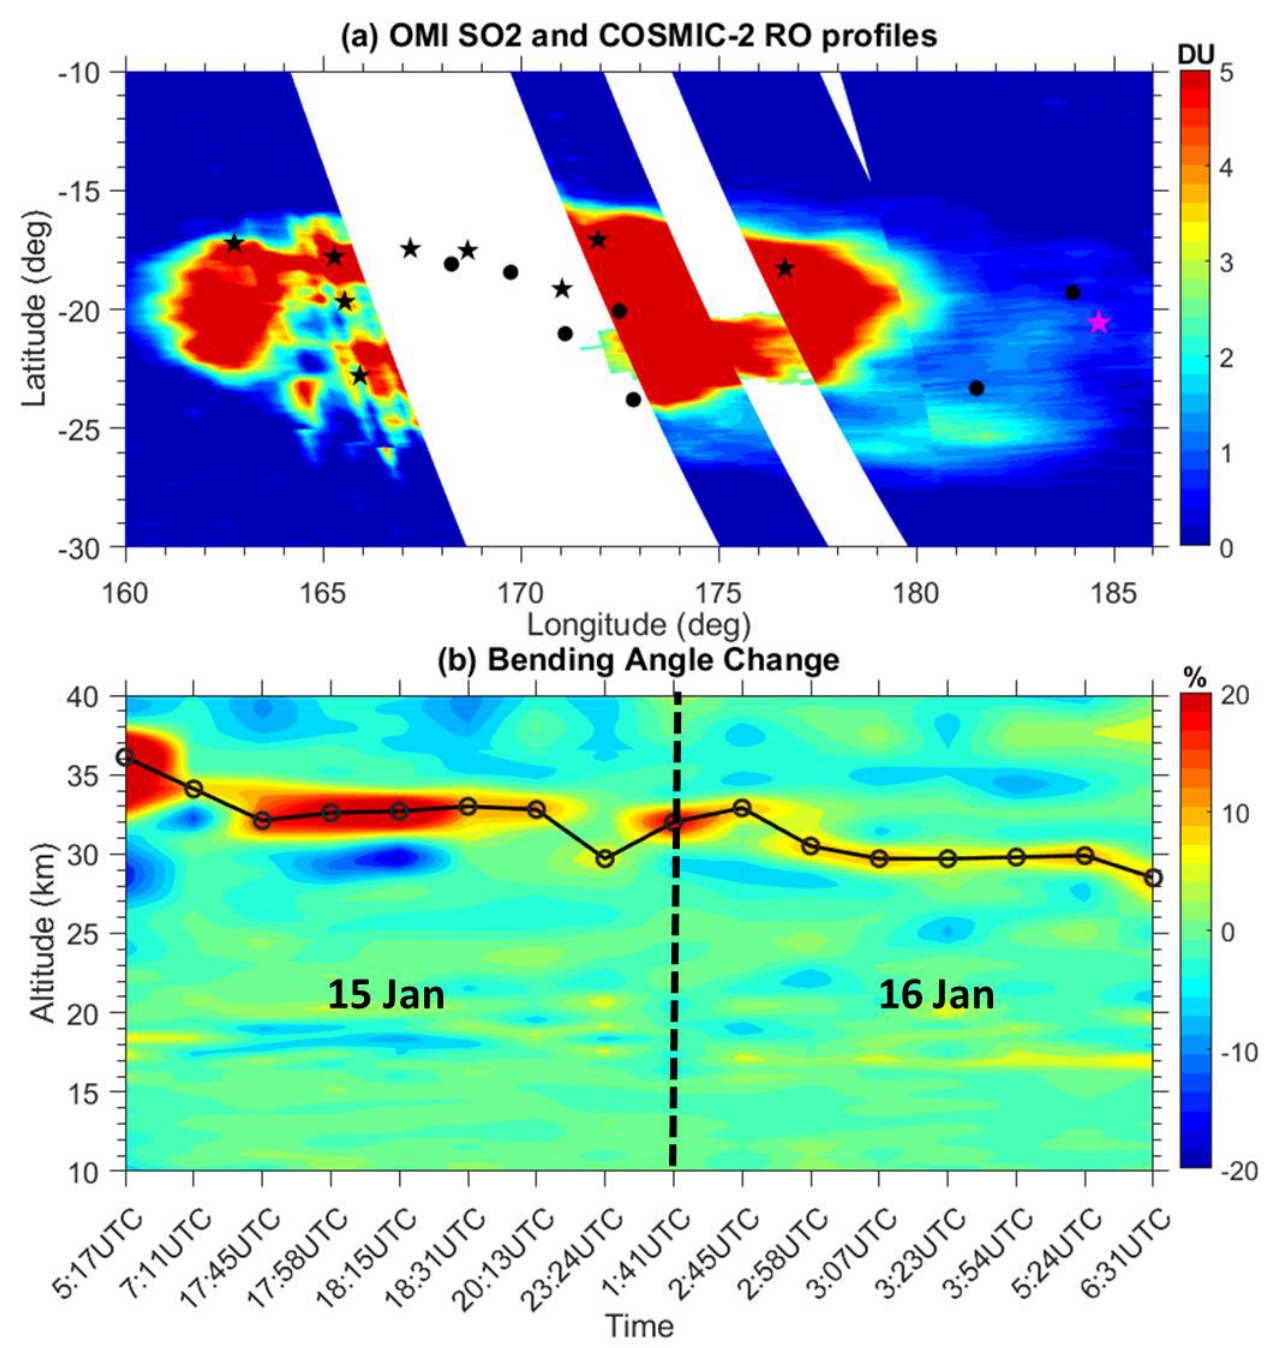
Figure 6. ( a ) OMI observed UTLS SO 2 on 15–16 January 2022 along with the available COSMIC–2 RO profiles on 15–16 January 2022, a time series of the distribution of ( b ) bending angle (BA) percentage change and the maximum BA peak altitude (black circles), for the aforementioned RO profiles. The black dots shown in subplot ( a ) represent the available RO profiles on 15 January and the black star dots for the available RO profiles on 16 January. The magenta–colored pentagram shown in subplot ( a ) represents the location of the Tonga volcano.